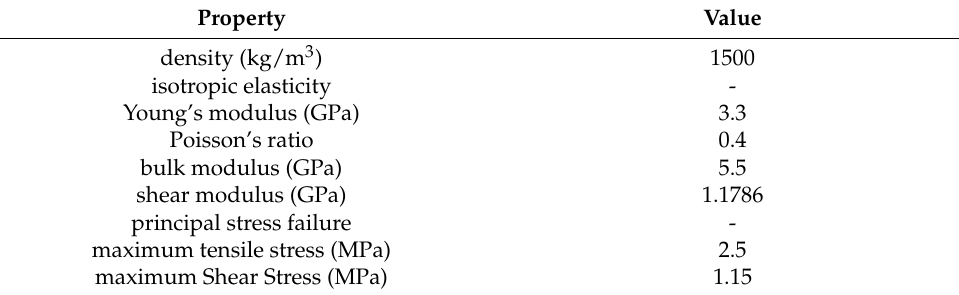
Table 4. The unsaturated polyester resin elastic parameters.